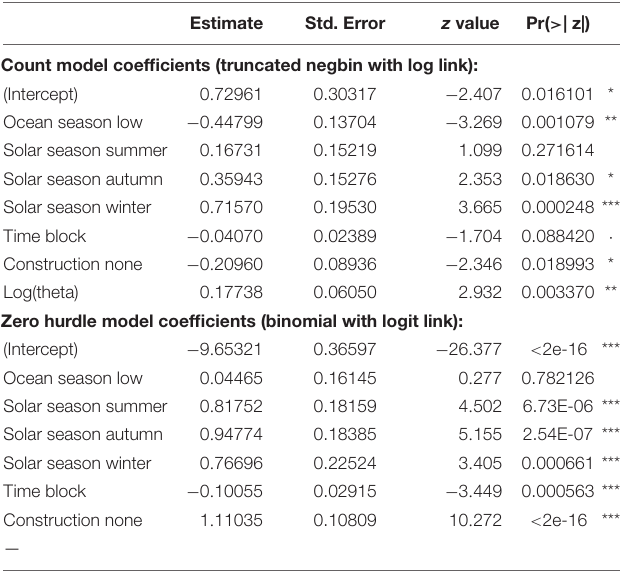
TABLE 4 | Summary of output for the plausible negative binomial hurdle model for Indo-Pacific humpback dolphin occurrence. Estimate Std. Error z value Pr( > |